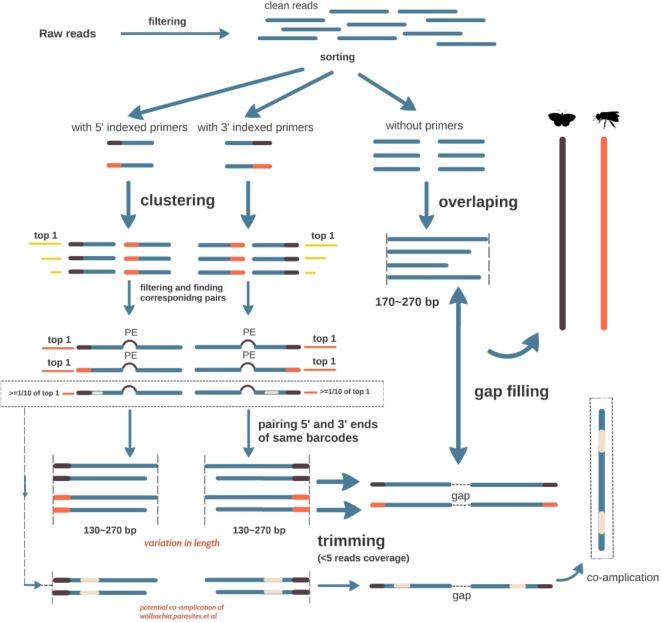
HIFI-Barcode assembly pipeline.